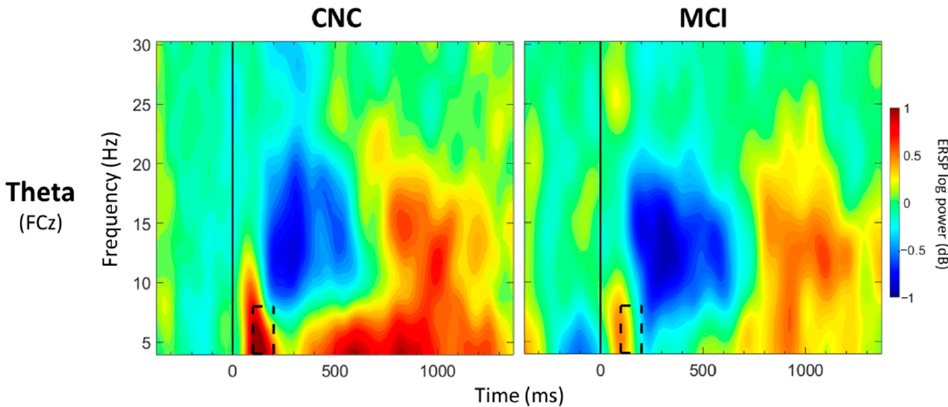
Figure 3. ERSP Comparisons for Main Effects of Group. Spectrograms illustrate differences between groups (CNC/MCI) for theta band (4–8 Hz) at FCz. The 0 ms time point (solid vertical line) represents stimulus onset. Dashed black rectangles indicate the time windows in which significant main effects of group were observed (also see Table 3). CNC: Cognitively normal older controls; MCI: mild cognitive impairment.